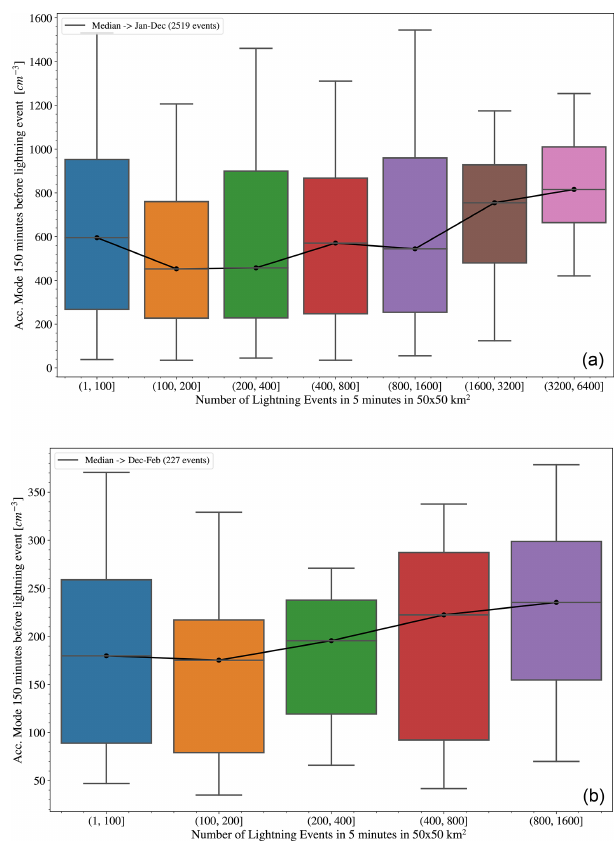
Figure 7. (a) Whisker diagram between lightning density classes and accumulation particle mode number concentration (60m sam- pling height), 150min before the maximum lightning density for the two analyzed years. (b) The same as (a) but for December to